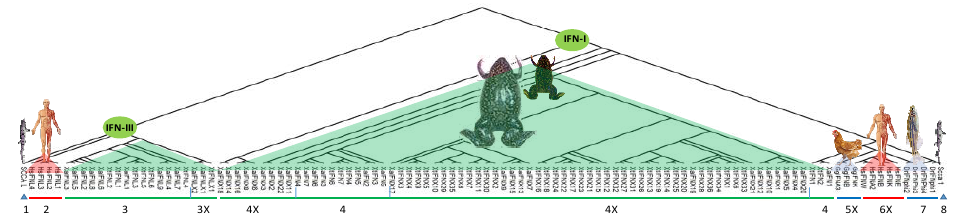
Figure 1. Schematic of vertebrate interferon (IFN) evolution and recent discovery about amphibian IFN complex. Evolutionary analyses were conducted in MEGA X [17]. The minimum evolution (ME) method was used to infer the molecular phylogeny, and the evolutionary distances were computed using the p-distance method, shown in the units of the number of amino acid differences per site. The ME tree was searched (search level of 1) using the close-neighbor-interchange (CNI) algorithm. The analysis used 108 amino acid sequences. All ambiguous positions were removed for each sequence pair. There was a total of 437 positions in the final dataset. In contrast to the previously known several fish-like intron-containing amphibian IFNs, recent studies revealed that amphibians are unique to have both fish-like intron-containing and amniotic intronless IFNs, which molecularly and immunologically stamp their amphibiotic position in vertebrate evolution [12,13,16]. Legends and Abbreviations: IFN-I, type I IFNs (including amniotic intronless IFNA, IFNB, IFNE, IFNK, IFNW, respectively, for the genes of IFN- α , - β , - ε , - κ , - ω ; and diverse amphibian intron-containing, XaIFN or XtIFN, and intronless